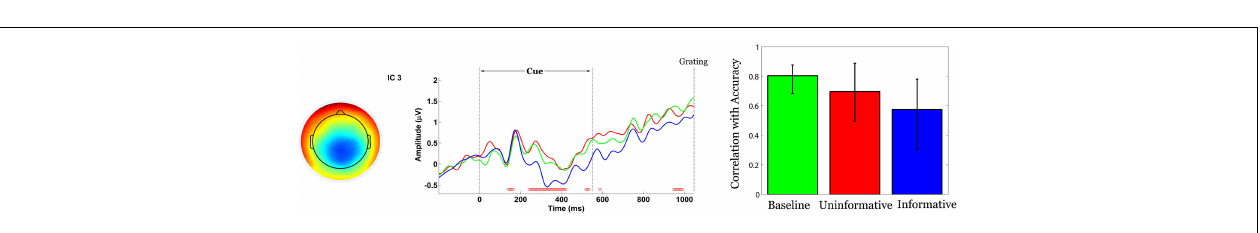
correspond to B, UC and IC conditions, respectively. Red dots above the abscissa indicate time points at which the correlation pattern is reliable by bootstrap test. Right: Correlation between component amplitude and identifi cation